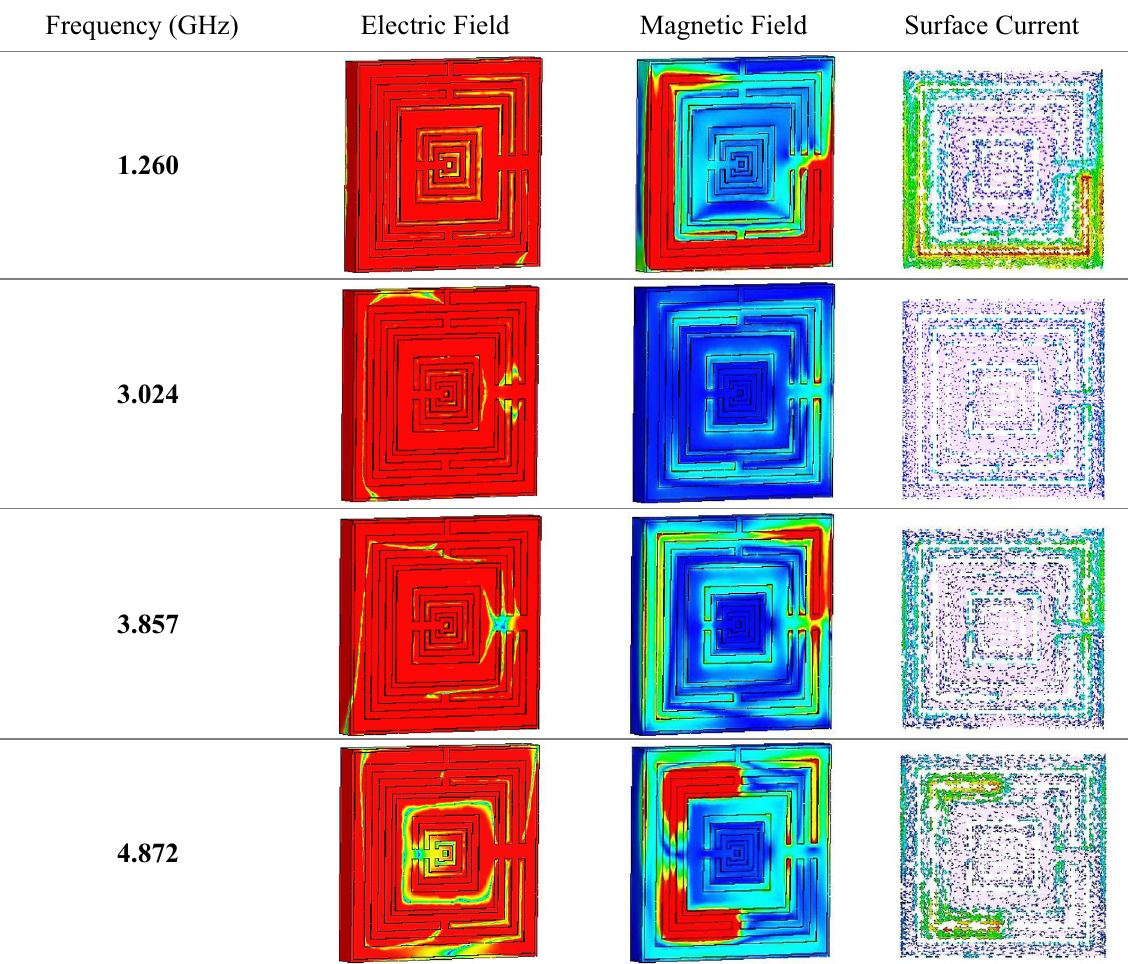
Table 3. Electric, magnetic field, and surface current distributions of the unit cell SM design for front